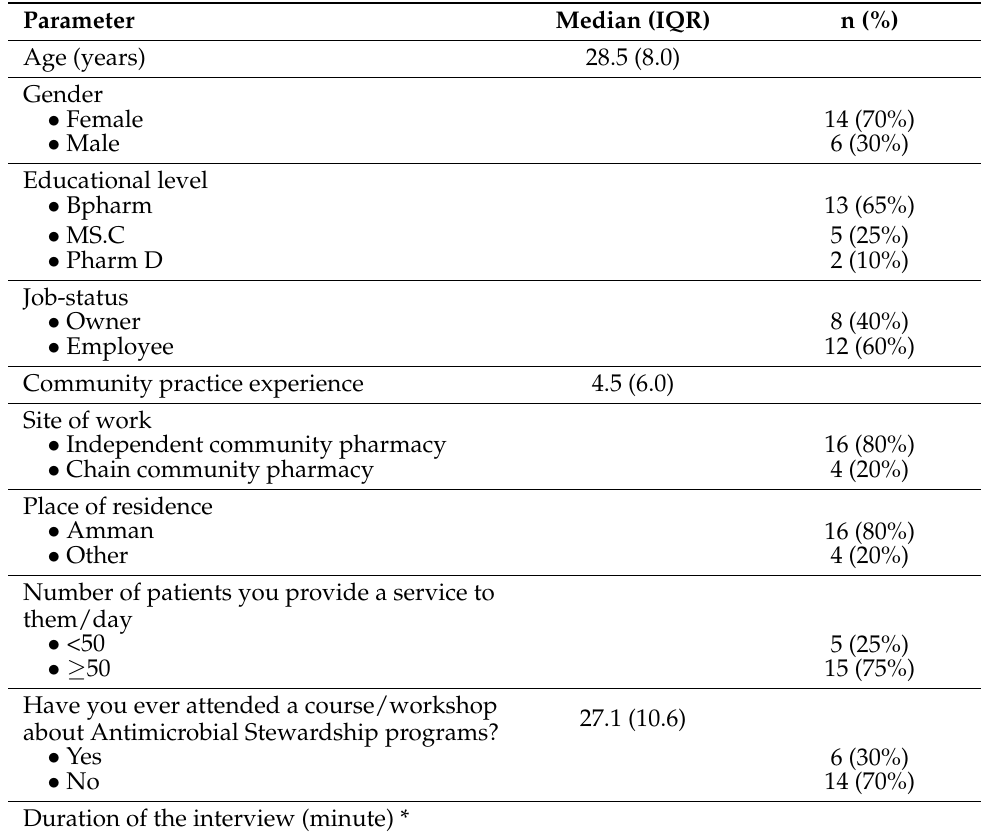
Table 1. Demographic characteristics of the study sample at baseline (n =